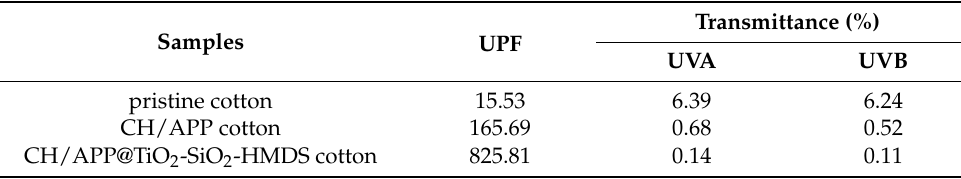
Table 5. UV-shielding properties of cotton fabric